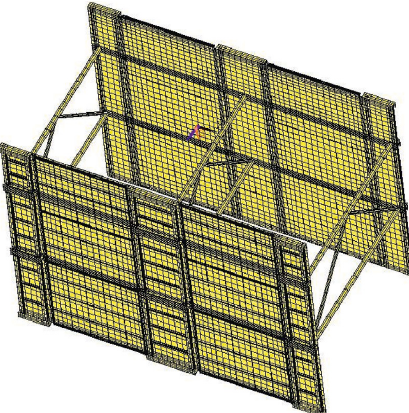
Figure 11: The finite element model of girder.